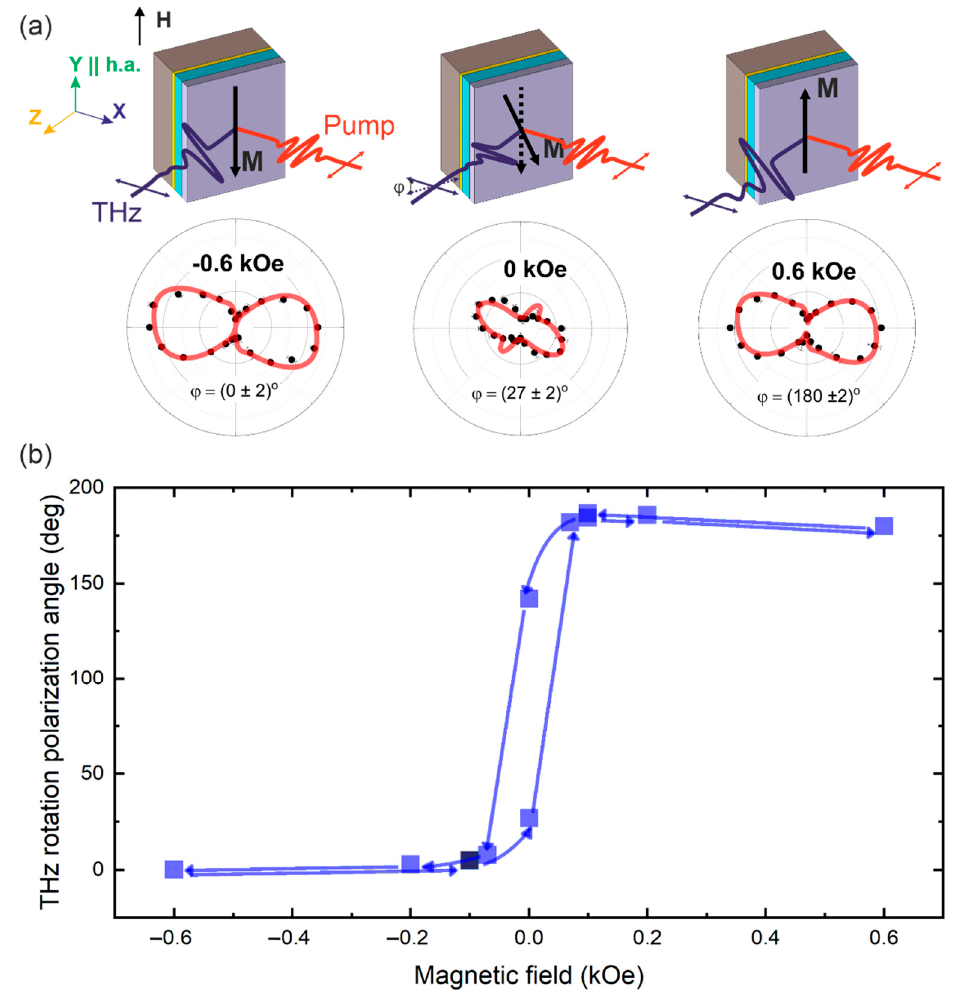
Figure 4. The dependence of the polarization angle of the THz field on the magnetic field in the “hard axis” geometry. ( a ) Angular diagrams of the THz signal (peak-to-peak THz amplitude as a function of the WGP rotation angle— φ 2) depending on magnetic field. The scale is the same for all angular dependencies. ( b ) Magnetic field dependence of the THz polarization angle obtained from the fittings of angular diagrams.